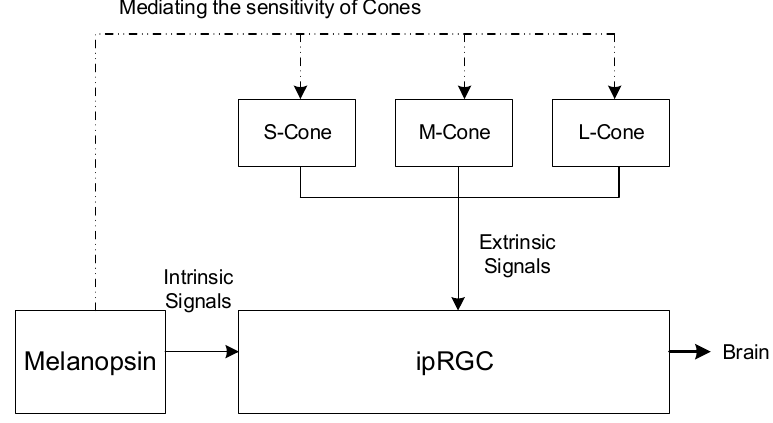
Figure 6. Hypotheses for the mechanism of pupil mediation with di ff erent